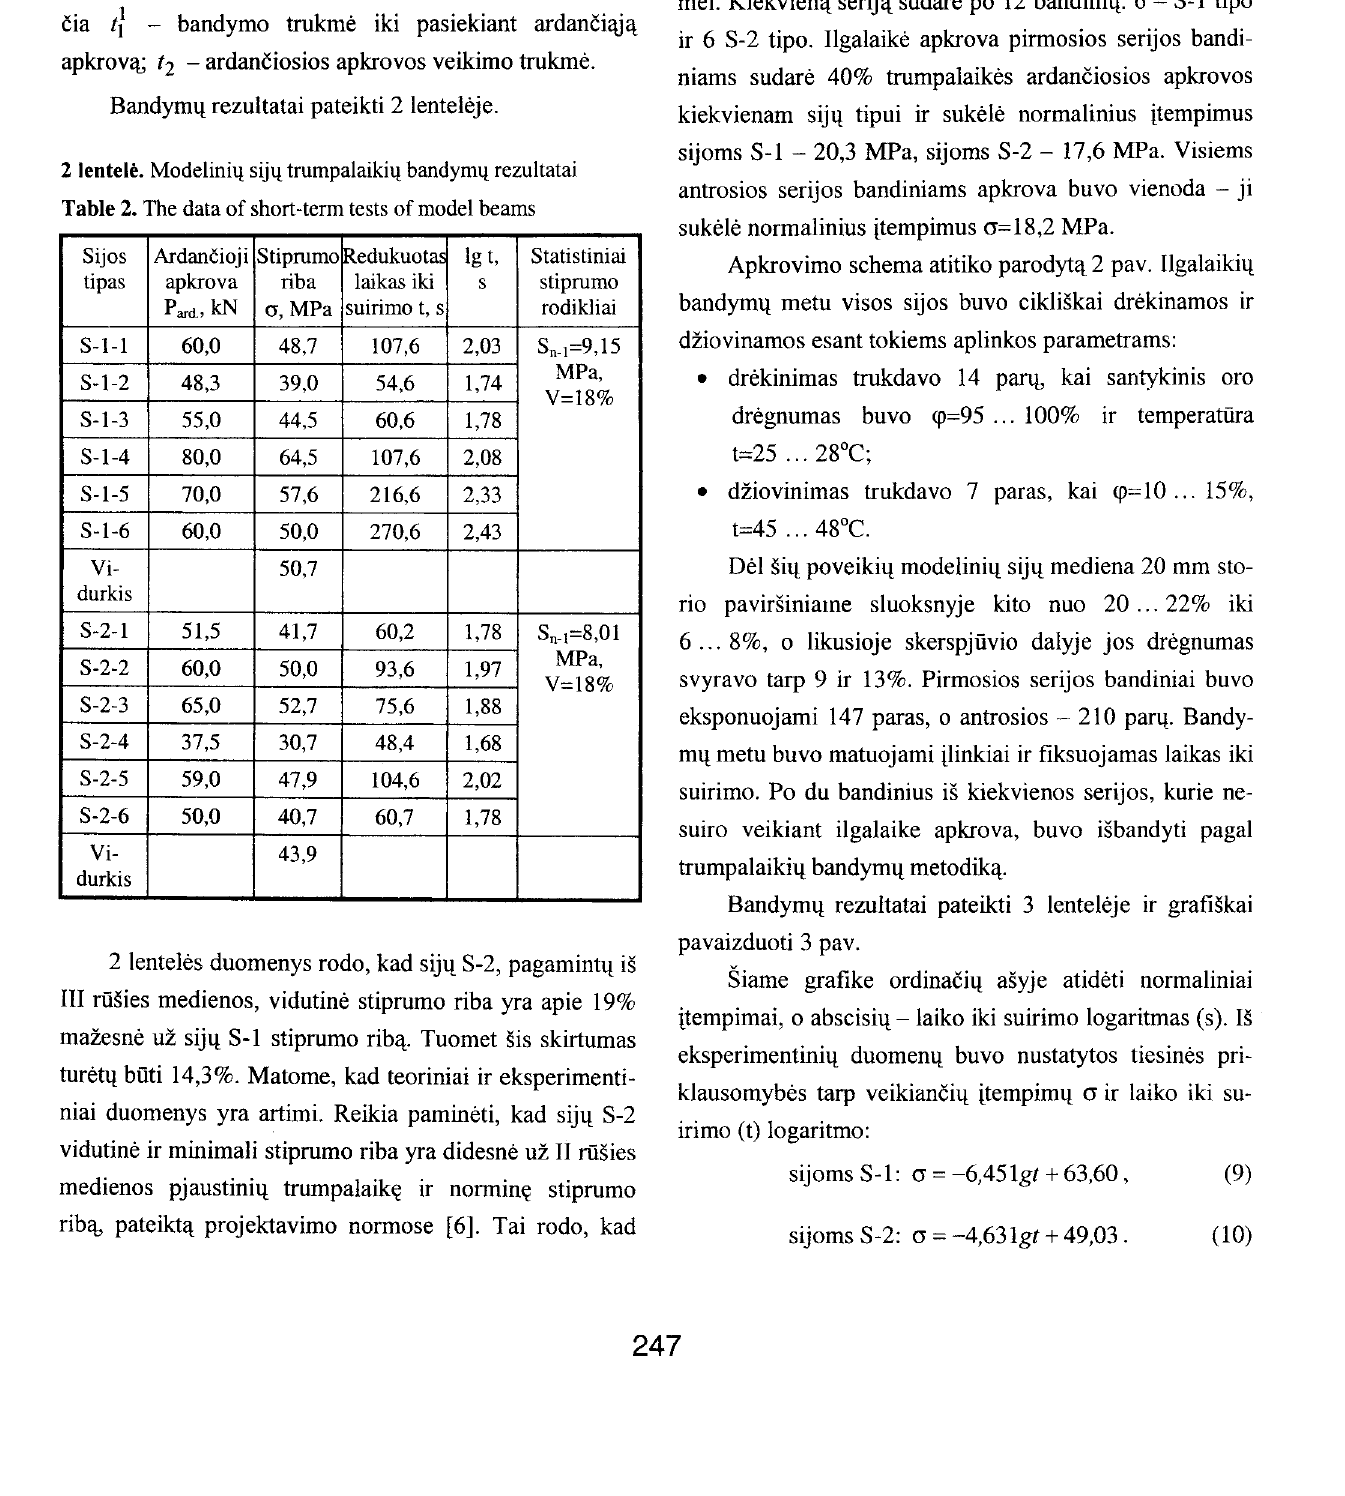
dregnumas buvo <p=95 ... 100% ir temperatUra t=25 ... 28°C; • dziovinimas trukdavo 7 paras, kai <p=10 ... 15%, t=45 ... 48°C.